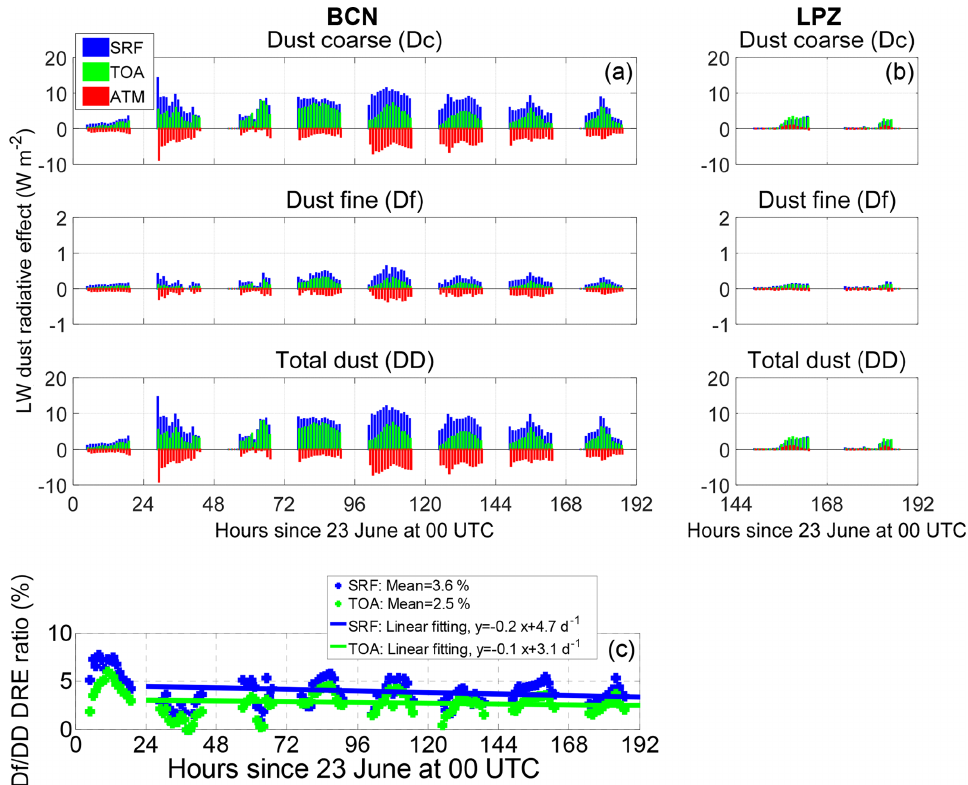
Figure 7. Long-wave instantaneous dust direct radiative effect (DRE LW ) at SRF, TOA and in the atmosphere (ATM) in (a) BCN and (b) LPZ. (c) Df / DD DRE ratio of the instantaneous DRE LW at the SRF and TOA in BCN; the mean values and best linear fits have been calculated between 24 and 30 June. The absolute decrease in Df / DD DRE LW ratio at the SRF (TOA) is − 0 . 2 ( − 0 . 1)%d − 1 .